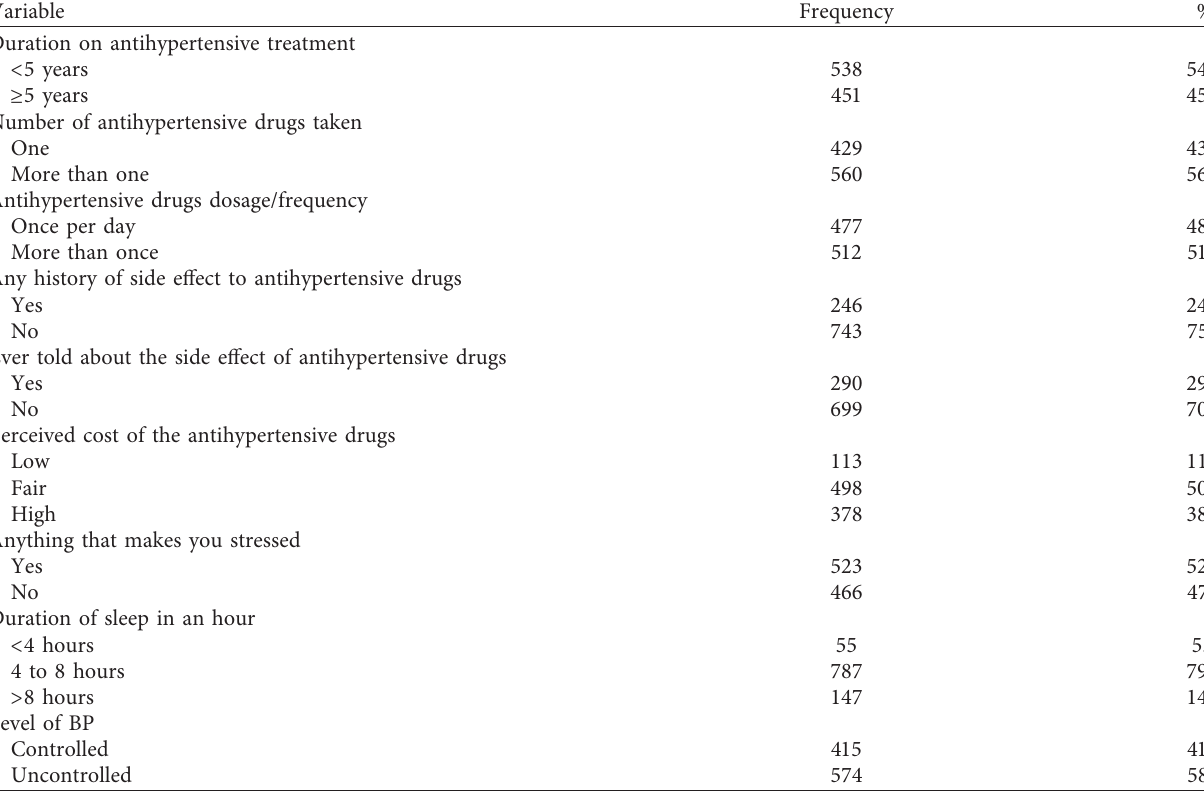
Table 3: Health-related conditions of hypertensive patients in Central Ethiopia, 2017 ( n �